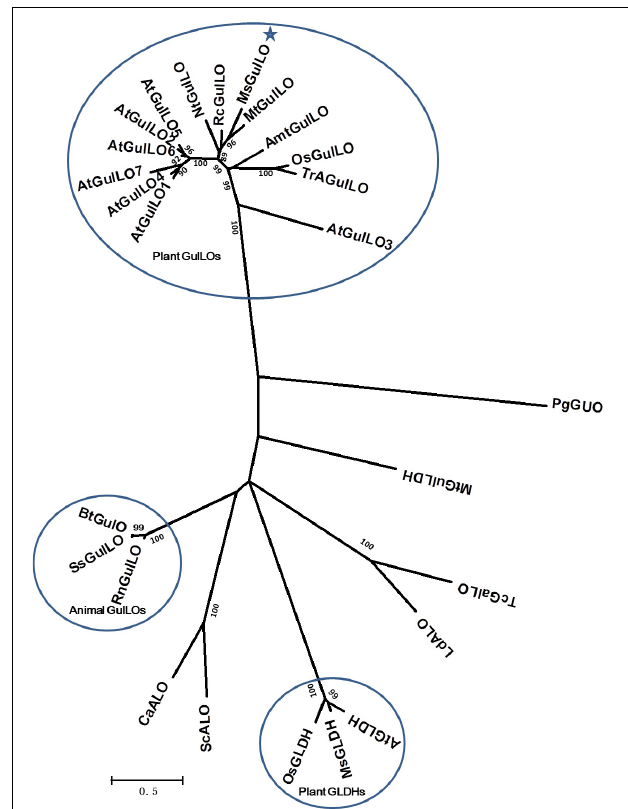
FIGURE 3 | Phylogenetic analysis of 26 terminal enzymes that are involved in the biosynthesis of AsA or its analogs. The phylogenetic relationship was reconstructed by using the Maximum Likelihood method and the Le and Gascuel (2008) model by Mega 7.0. MsGulLO is indicated by a star. Plant GulLOs, plant GLDHs, and animal GulLOs are circled. Numbers on branches indicate the bootstrap percentage values ( > 80%) calculated from 1000 bootstrap replicates. The species used in the unrooted phylogeny tree construction are as follows, with names followed by accession number. GulLOs from plants: Amborella trichopoda (AmtGulLO; W1PKS5), Arabidopsis thaliana (AtGulO1 to AtGulO7; Q9C614, Q6NQ66, Q9LYD8, Q9FM82, O81030, O81032, and Q9FM84), Medicago truncatula (MtGulLO; A0A072TYF3), Mucuna sempervirens (MsGulLO; A0A290U7F5), Nicotiana tabacum (NtGulLO; A0A1S4B1A6), Oryza sativa (OsGulLO; Q10I64), Ricinus communis (RcGulLO; B9SVF9), Triticum aestivum (TrAGulLO; A0A077RZP9); GulLOs from animals: Bos taurus (BtGulLO; Q3ZC33), Rattus norvegicus (RnGulLO; P10867), Sus scrofa (SsGulO; Q8HXW0); GLDHs from Arabidopsis thaliana (AtGLDH; Q9SU56), Mucuna sempervirens (MsGLDH; AVM41577), Oryza sativa (OsGLDH; Q2QXY1); ALOs from Candida albicans (CaALO; O93852), Leishmania donovani (LdALO; C8CCV9), Saccharomyces cerevisiae (ScALO; P54783). GulLDH from Mycobacterium tuberculosis (MtGulLDH; P9WIT3). GalLO from Trypanosoma cruzi (TcGalLO; Q4DPZ5). GUO from Penicillium griseoroseum (PgGUO;